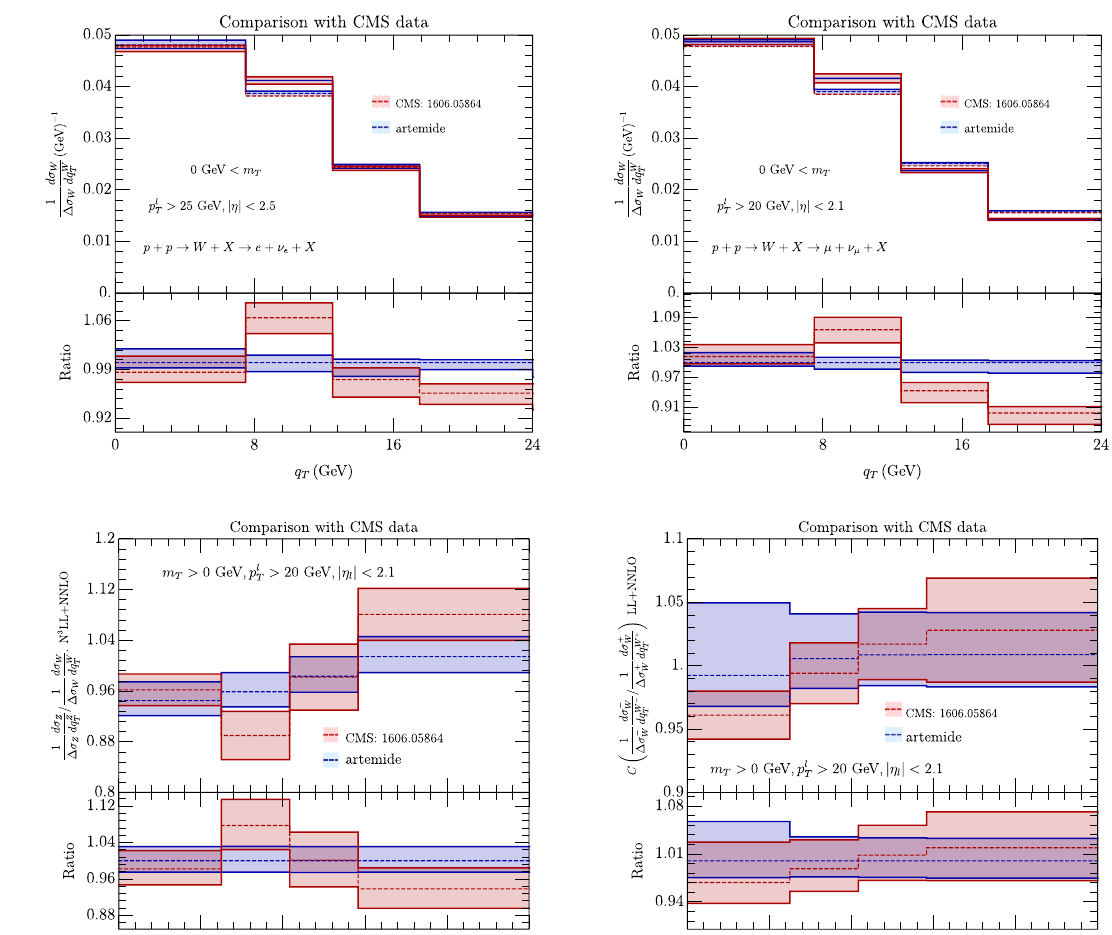
Fig. 14 Comparison of our prediction with data from D / 0 experiment at s = 1 . 8 TeV [13]. Theoretical predictions include errors coming from scales